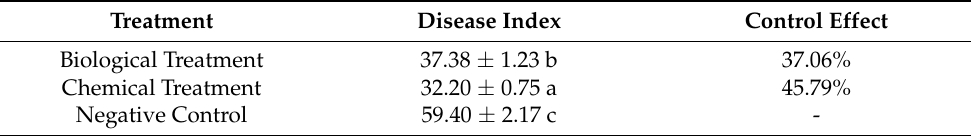
Table 3. Control effect of P. polymyxa strain SF05 on maize to banded leaf and sheath blight in the